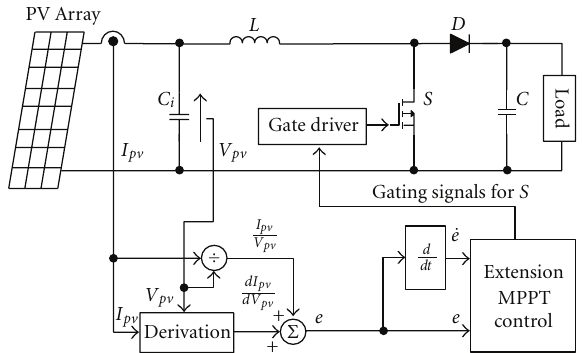
Figure 6: Structural diagram of the proposed extension MPPT system.